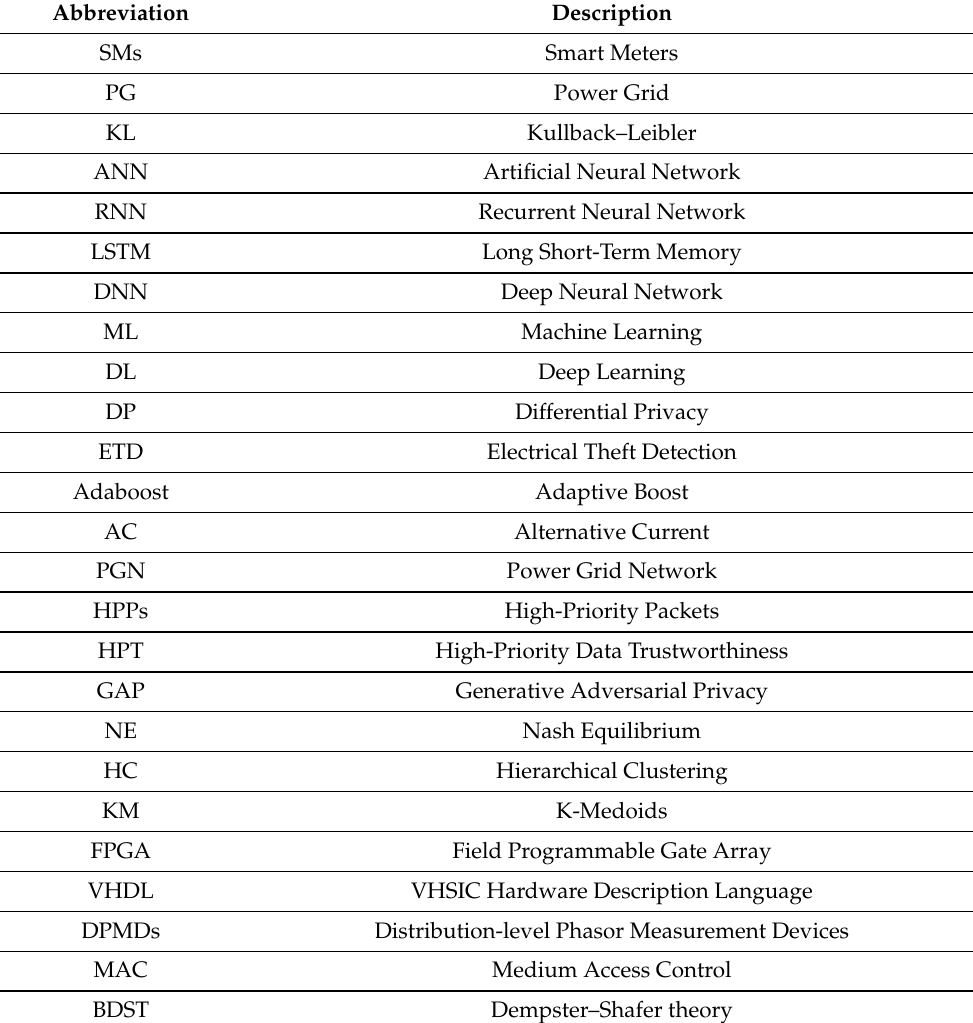
Table 1. List of